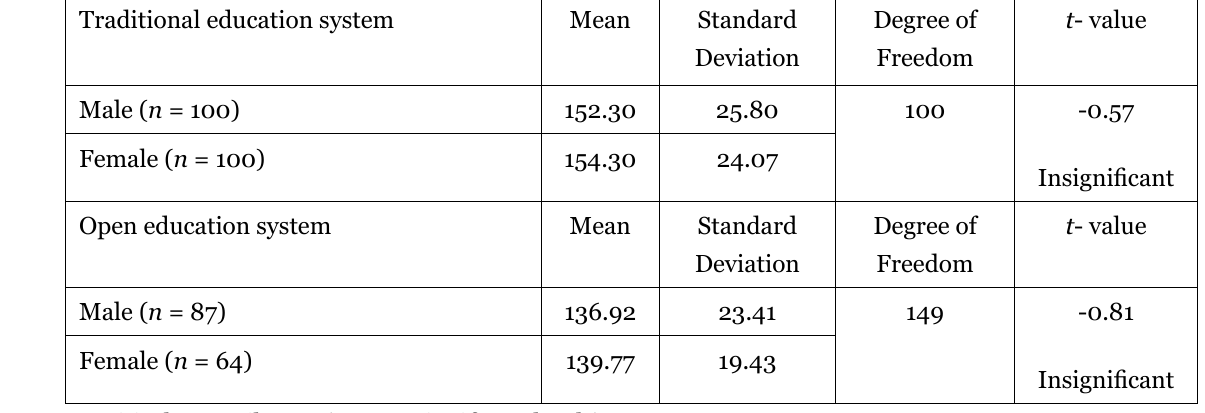
T-Test Analysis of Academic Motivation of Male and Female Students Studying in TES and OES Traditional education system